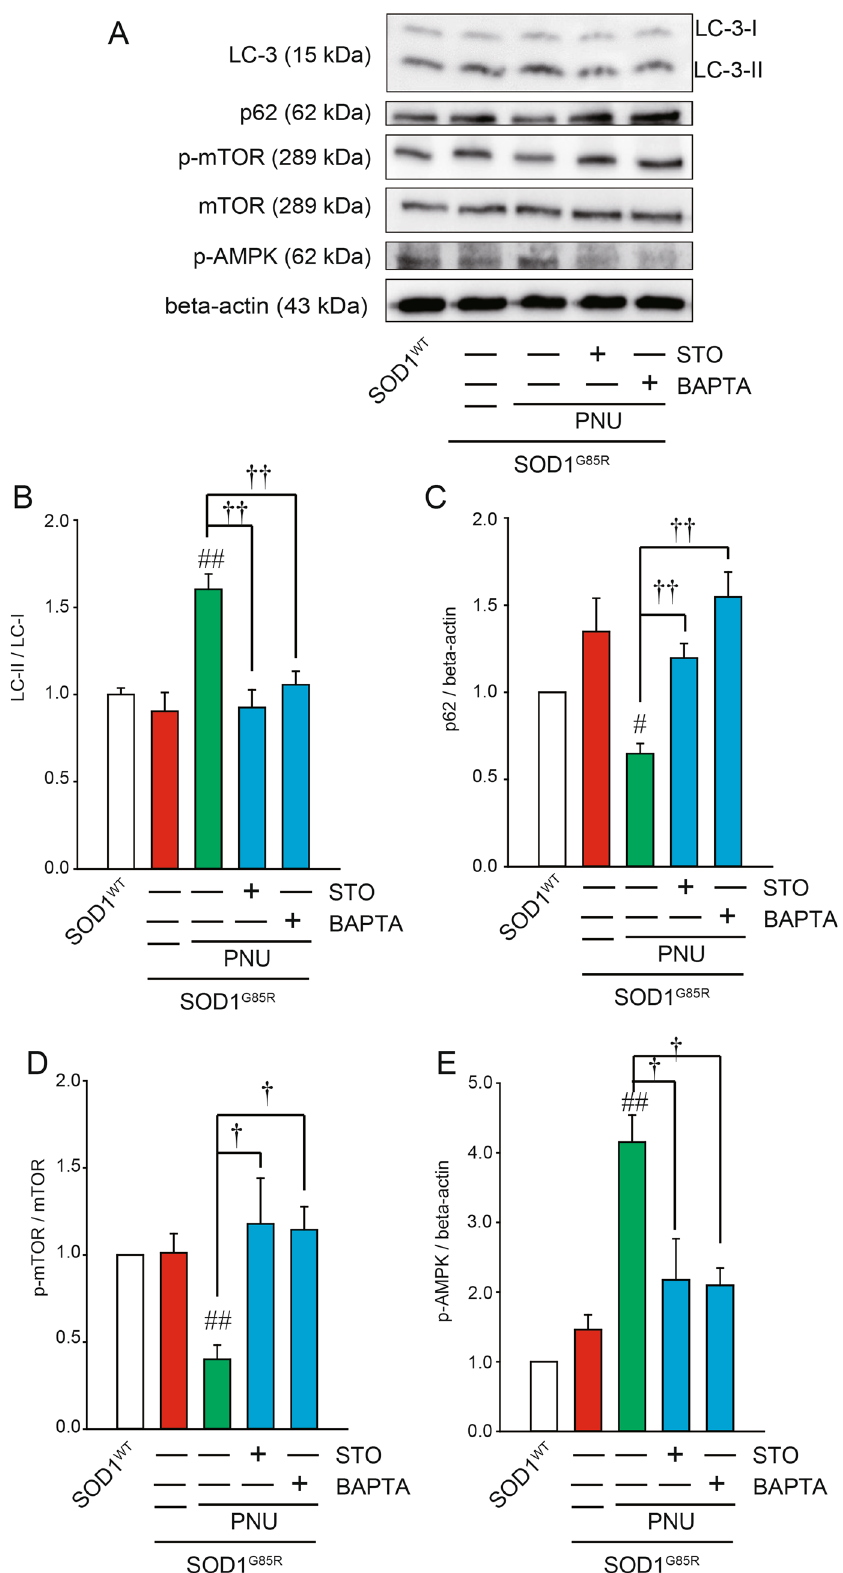
Figure 3. PNU282987-induced Ca 2+ influx contributes to autophagy. Immunoblotting analysis of autophagy regulators with a Ca 2+ chelator and CaMKK-specific inhibitor. N2a cells expressing SOD1 G85R were treated with 1 µM PNU282987 (PNU) in the presence or absence of 1 µM STO609 (STO) or 1 µM BAPTA-AM (BAPTA) pretreated before 30 min. ( A ) The lysates were analyzed by immunoblotting with antibodies for LC-3, p62, phosphorylated mTOR (p-mTOR), mTOR, phosphorylated AMPK (p-AMPK), β-actin. ( B – E ) Relative levels normalized by the expression of LC3-I or mTOR or β-actin were quantified, based on the density of SOD1 WT . Data is expressed as mean ± SEM from three independent experiments. Significance: # p < 0.05, ## p < 0.01 vs. SOD1 G85R ; † p < 0.05, †† p < 0.01 vs SOD1 G85R with PNU282987 by One-way